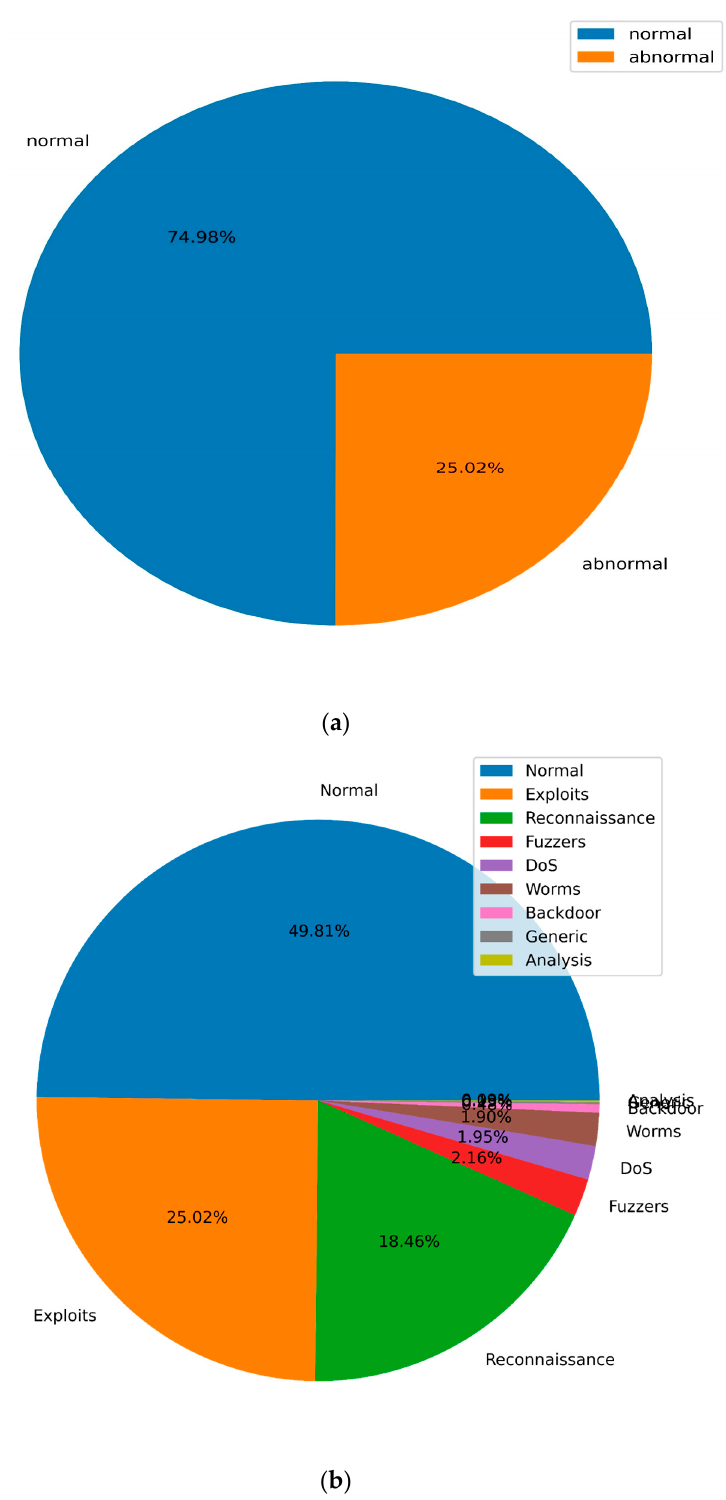
Figure 2. The distribution of labels ( a ). Binary (train) ( b ). Multiclass (train).